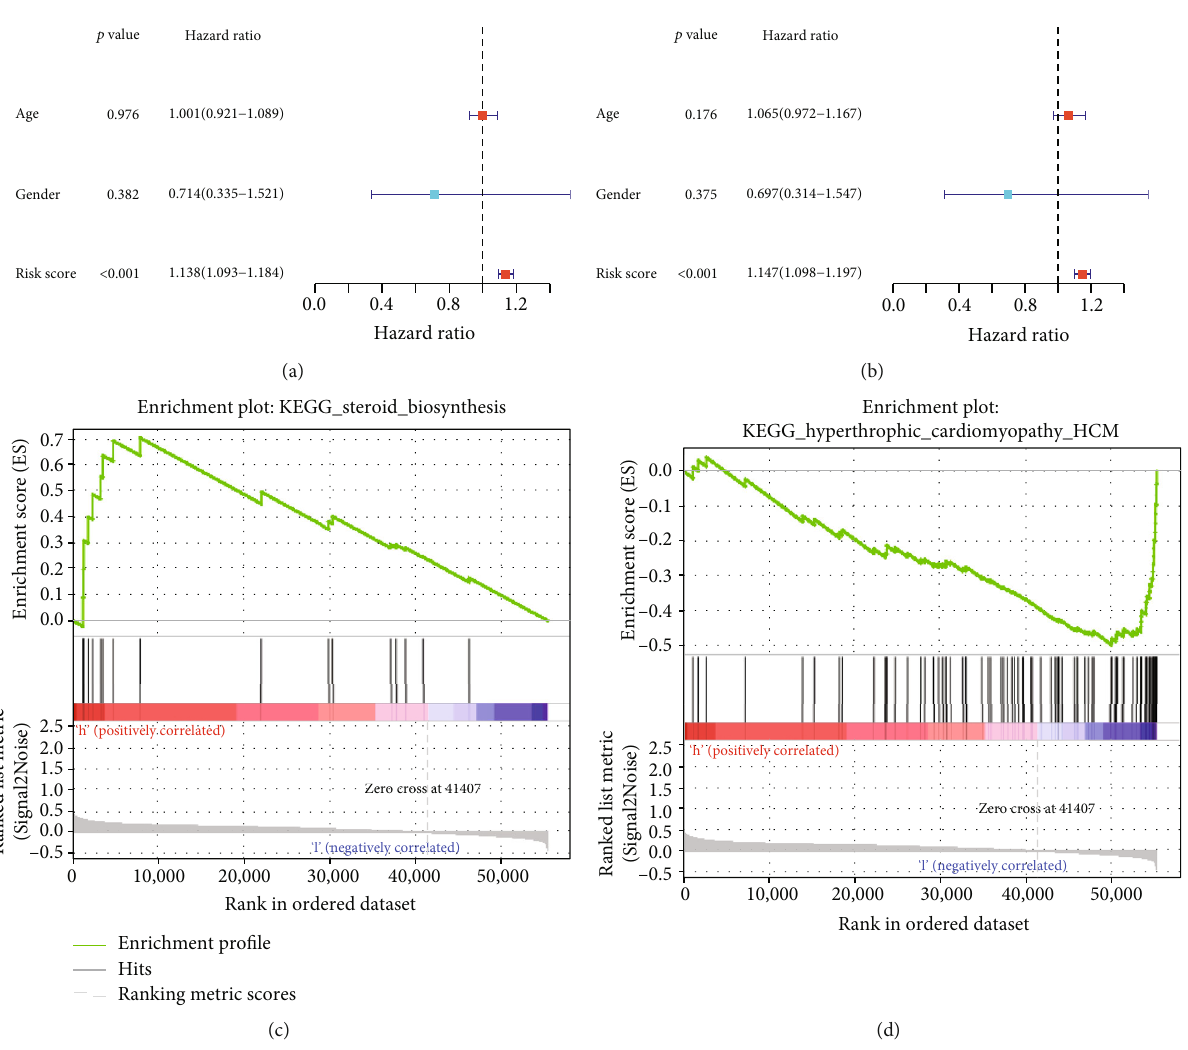
Figure 9: Evaluation of the independency of EMT score in osteosarcoma prognosis and its relevant signaling pathways. (a, b) Uni- and multivariate cox regression models for determining the independency of EMT score in estimating osteosarcoma survival outcomes in the TARGET cohort. (c, d) Signaling pathways that were remarkably linked to EMT score via